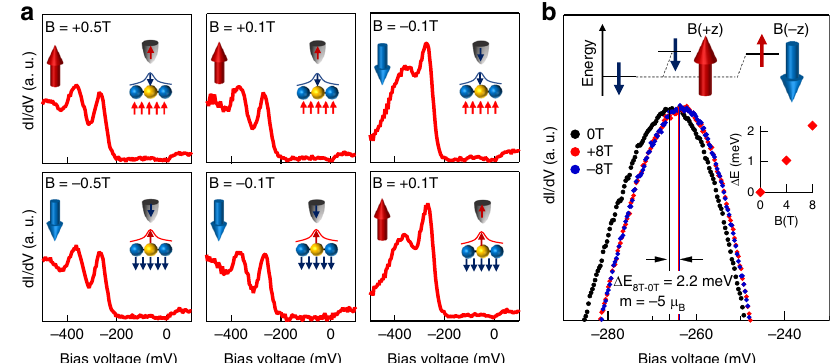
Fig. 2 Magnetic nature of the impurity bound state. a Dependence of the impurity state with Ni tip under a weak magnetic fi eld. We apply + 0.5 T, + 0.1 T, − 0.1 T, − 0.5 T, − 0.1 T, + 0.1 T fi elds to systematically fl ip the magnetization of the tip and sample. The inset schematics illustrate the respective spins of the tip and the impurity state that is anti-aligned with bulk magnetization direction. b Dependence of the impurity state with a strong magnetic fi eld. Under both + 8 T and − 8T, the peak exhibits a magnetization-polarized Zeeman energy shift of 2.2 meV, which amounts to an effective moment of − 5 µ B . The inset data shows the energy shift for different magnetic fi eld magnitudes. Inset schematic illustrates the magnetization-polarized Zeeman effect. The applied fi eld aligns the spins of the impurity state in the same orientation, hence + z and - z orientation fi elds lead the energy to shift in the same